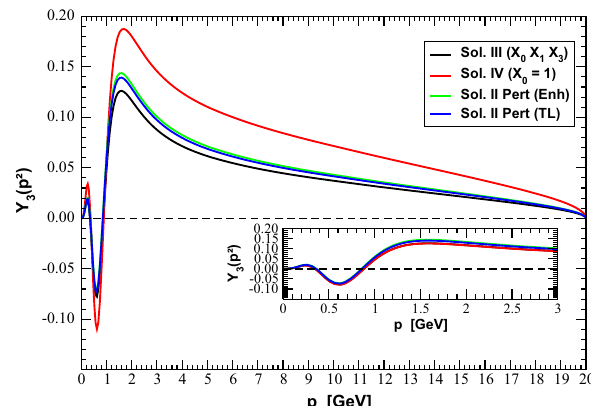
Fig. 27 The quark-ghost kernel form factor X 0 ( p 2 )